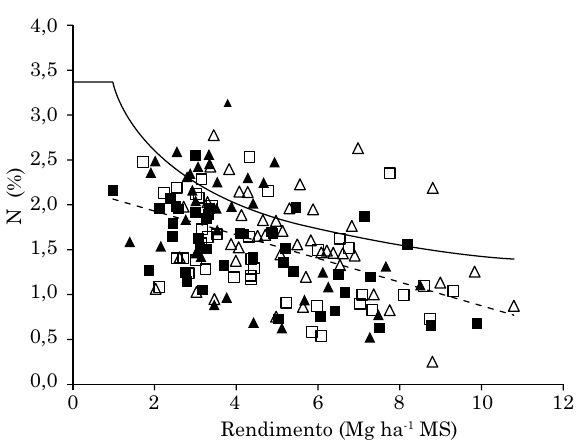
Figura 3. Curva de diluição de nitrogênio (-) e relação entre teor de n e rendimento da cultura de milho fertilizada pela adubação sistêmica em Sistemas Integrados de produção agropecuária (─ ─) ( ŷ = 2,21 - 0,132 x; p<0,0001; R² = 0,2280; DPR = 0,50; e n = 159). Tratamentos: □ Contínuo moderada; ■ Rotativo moderada; ∆ Contínuo baixa; e ▲ Rotativo baixa.